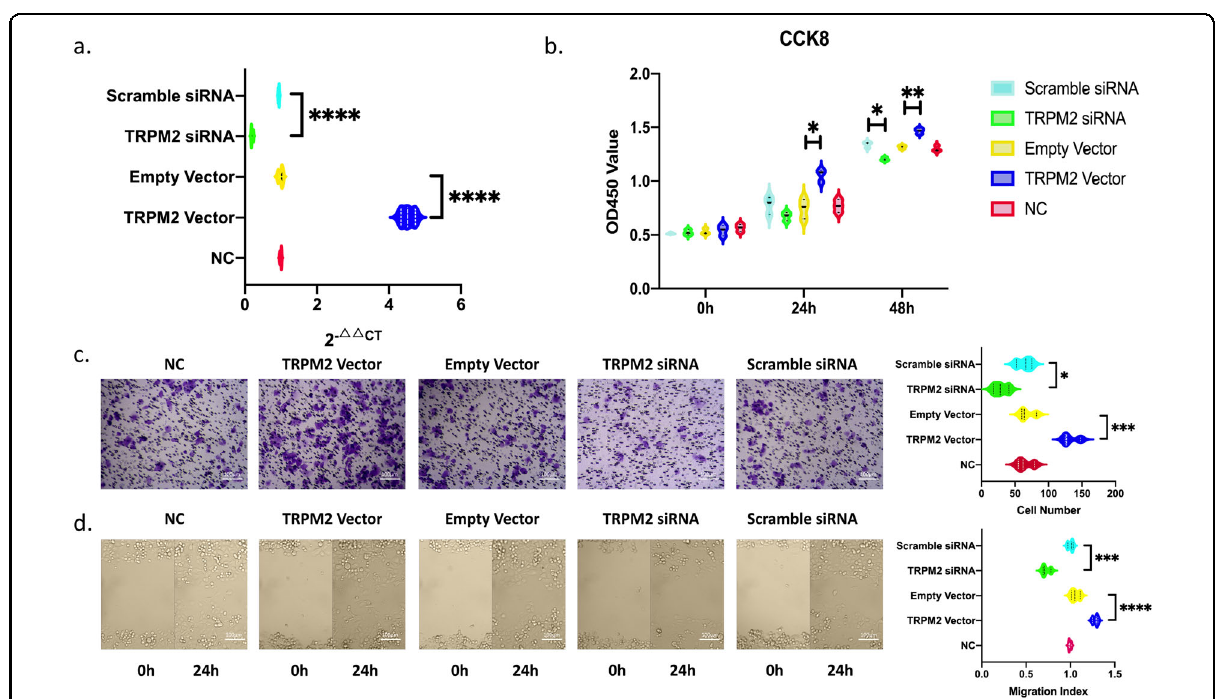
Fig. 3 TRPM2 promotes the proliferation, migration and invasion of BxPC-3 pancreatic cancer cells. a qRT-PCR results of TRPM2 expression level in different experimental groups of BxPC-3 cells: TRPM2 overexpressed (TRPM2), TRPM2 siRNA, scramble siRNA, empty vector (Empty_Vec), and normal control (NC) groups. **** P < 0.0001. b CCK8 assay results of different groups at 0-, 24-, and 48-h time intervals. * P < 0.05, ** P < 0.01, siRNA, small interfering RNA; CCK8, cell counting kit-8; OD, optical density. c Transwell assay results showed that the TRPM2 overexpression group has a stronger invasive ability and TRPM2 siRNA group has a weaker invasive ability. Images under microscopy (magni fi cation ×100). * P < 0.05. d Scratch wound healing assay results. Images of all groups at 0- and 24-h time intervals post injury (magni fi cation ×100). * P < 0.05, ** P < 0.01 (3 repeats for each